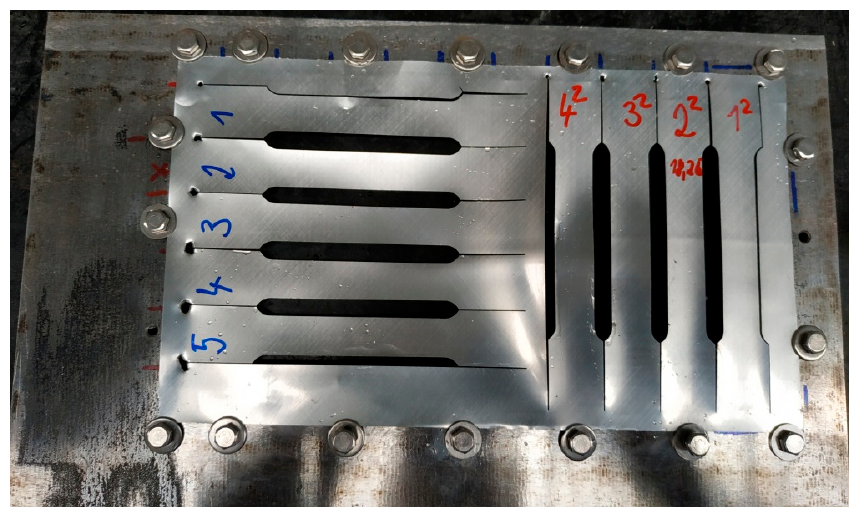
Figure 6. Manufactured specimen for static tensile test, blue mark = axial orientation of material fiber, red mark = radial orientation of material fiber.